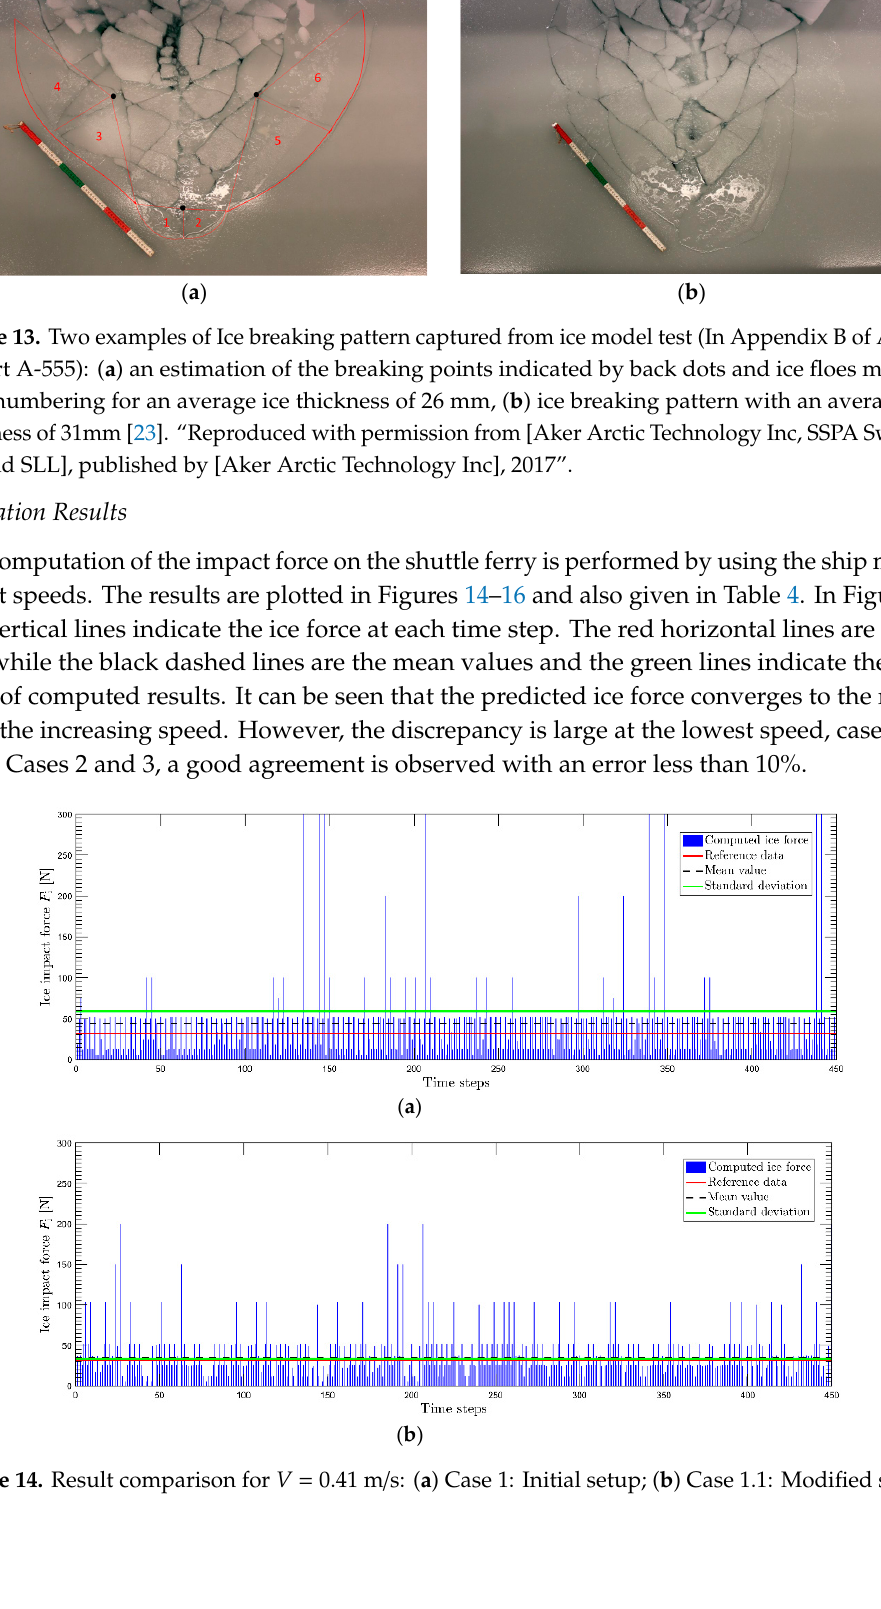
Figure 15. Case 2: Result comparison for speed V = 0.92 m/s . Figure 16. Case 3: Result comparison for speed V = 1.38 m/s .